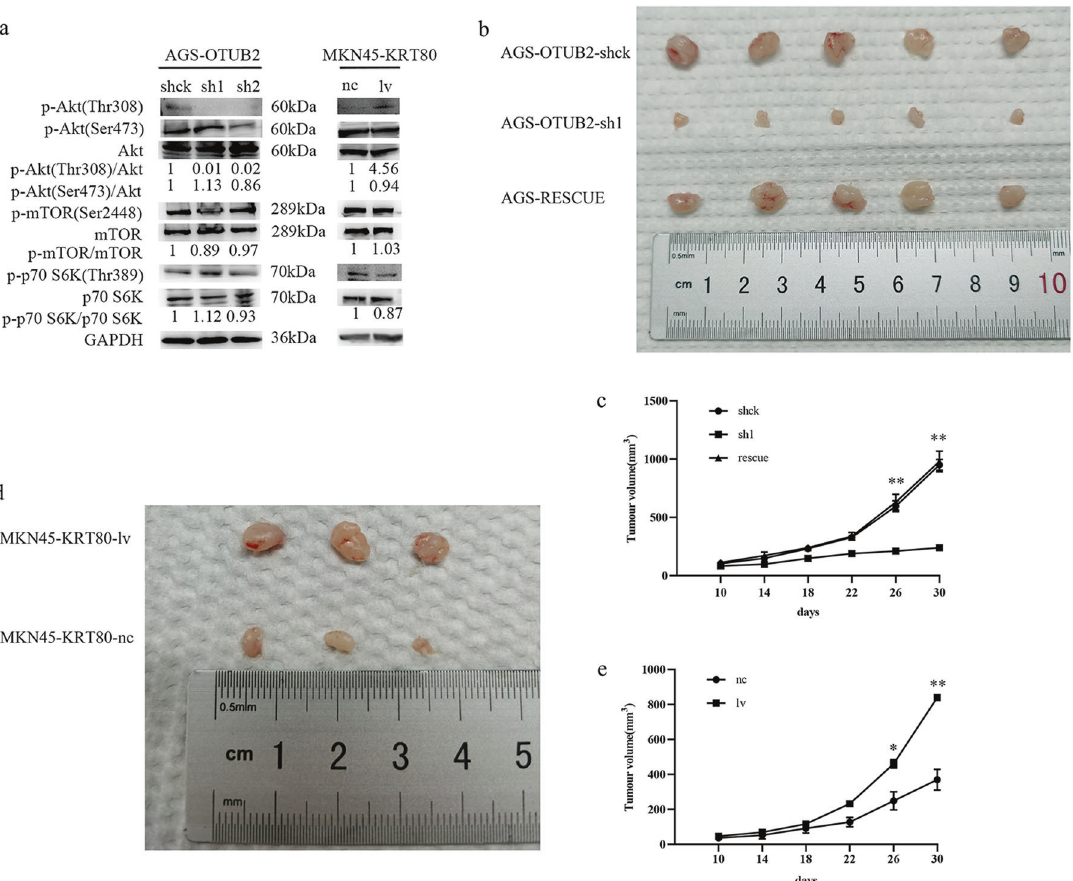
and GAPDH served as controls. Increased Akt phosphorylation levels, as detected by western blotting, in KRT80-overexpressing MKN45 cells. b – e Effect of OTUB2-knockdown, KRT80 rescued and control AGS cells ( b ) or KRT80-overexpression MKN45 cells ( d ) on GC tumorigenesis in vivo. The volume of subcutaneous tumors was measured ( n = 5 or n = 3). * P < 0.05; ** P < 0.01 (Student ’ s t